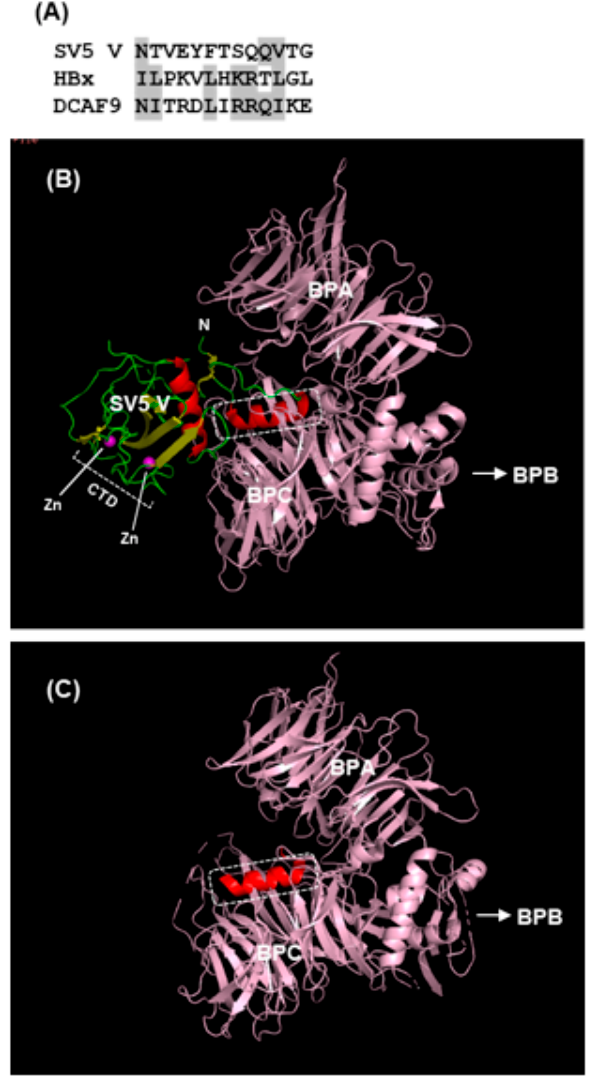
Figure 6. ( A ) Multiple alignment of the DDB1-interacting sequences in two viral proteins and a DCAF (DDB1–Cullin-interacting factor); the similar residues are highlighted. Portions of the cocrystal structure of DDB1 with ( B ) SV5 V protein and ( C ) the central H-box helical fragment of HBx (hepatitis B virus X protein). This is a PyMol presentation of PDB 2B5L and 3I7H, respectively [105,106]. Colors used are: V protein is green, except the helices, which are red; the H-box helix of HBx is also red; the zinc atoms are magenta; DDB1 is light pink. In the V protein, the N-terminus, the C-terminal domain (CTD), and the two zinc atoms in the CTD (as in Figure 5) are labeled. The boxed helices in both panels are structurally similar to each other, and both interact with DDB1 in a region between β -propellers A and C (BPA and BPC); the primary structures of these same helices are shown in panel ( A ). The β -propeller B is not shown to save space, but its direction is indicated with the arrowhead. Note that the DDB1 structure in panels ( A , B ) are essentially identical, although they may appear somewhat different because the images were rotated for the best visual alignment of the DDB1-interacting helices (boxed) in the two panels, without regard to DDB1 orientation. DDB1 additionally forms a stable complex with Cul4A [111], suggesting a moonlight- ing role of the DNA-damage-binding DDB1 as a core subunit of the ubiquitin ligase com- plex, recently confirmed in a comprehensive analysis of the IFN-antagonistic mechanisms of diverse viruses, including herpes viruses and HIV (a retrovirus) [112]. In paramyxovi- ruses, in particular, the viral VADCs contain DDB1–Cul4A–Roc1 [62,105,113], representa-